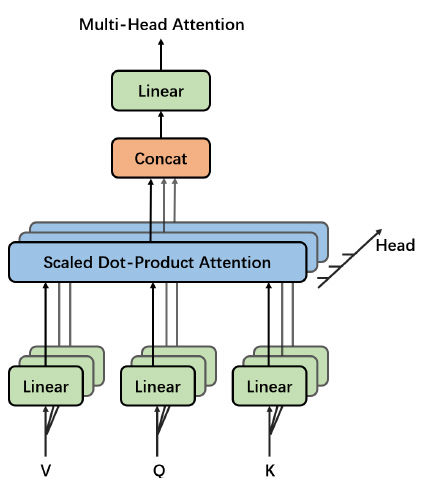
Figure 4. The structure of multi-head attention